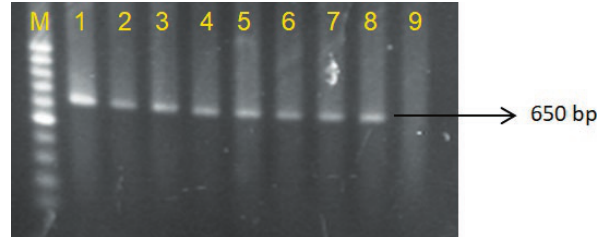
Figure 3. Gel from extracts of onion, garlic, cucumber, and melon plants mechanically inoculated with two onion isolates of CMV in the host indexing study gave positive results in RT-PCR to ampli- fy partial RNA2 of CMV (650 bp). Isolate CMV-14.3Po in lane 1. onion, lane 2. garlic, lane 3. cucumber, and lane 4. Melon. Isolate CMV-15.5Po in lane 5. onion, lane 6. garlic, lane 7. cucumber, lane 8. Melon. Lane 9. negative control (uninoculated onion). Lane M = 100 bp DNA ladder marker (Thermo Fisher